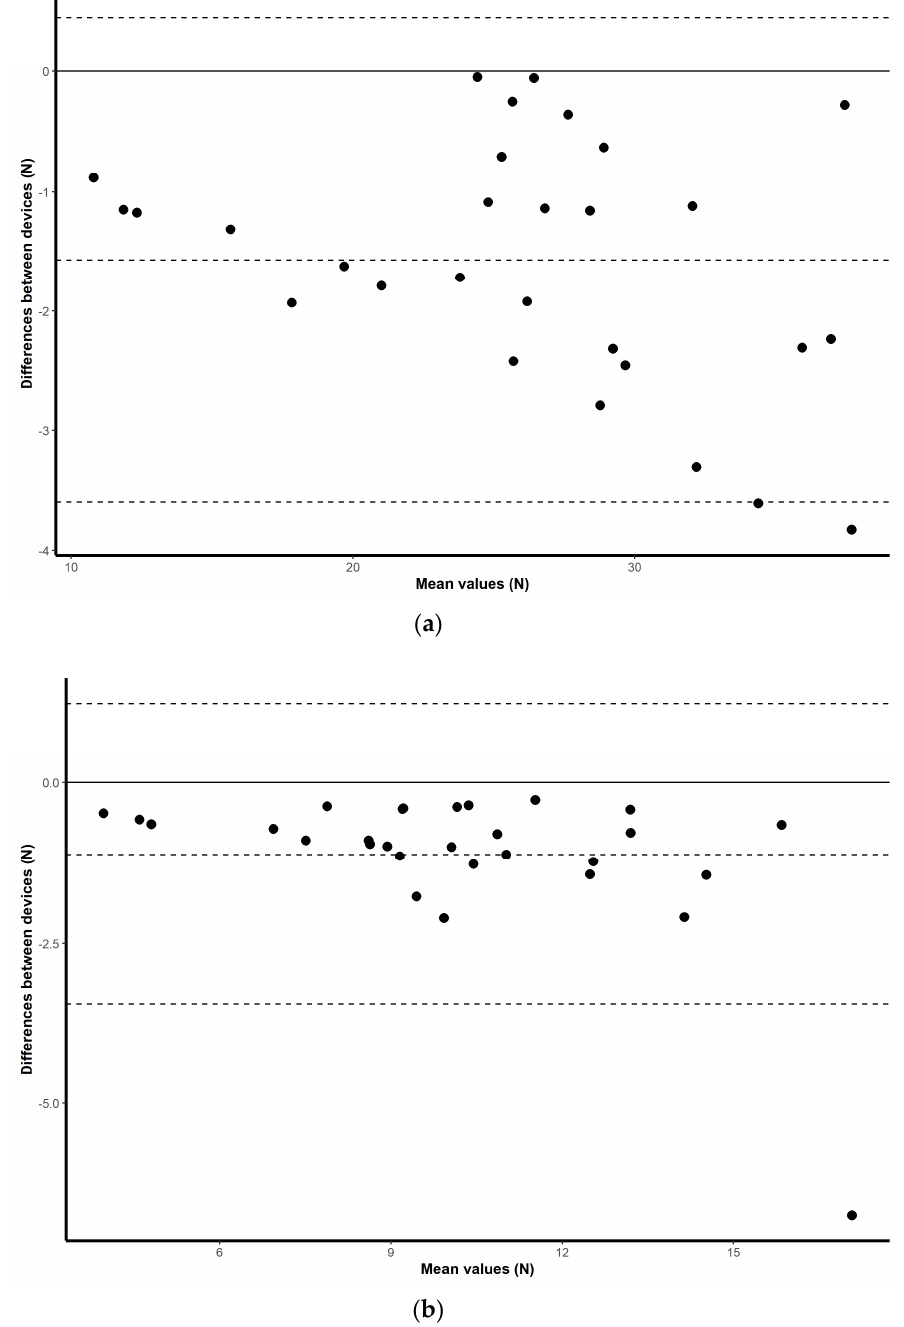
Figure 9. Session two mean difference plot comparison of the results from the HX711 microcontroller- based load cell and the signal conditioner for: ( a ) maximal isometric leg extension; ( b ) maximal isometric bicep flexion. The middle-dashed line represents the mean difference and the upper and lower dashed lines represent the 95% limits of agreement (mean ± 1.96 * SD).